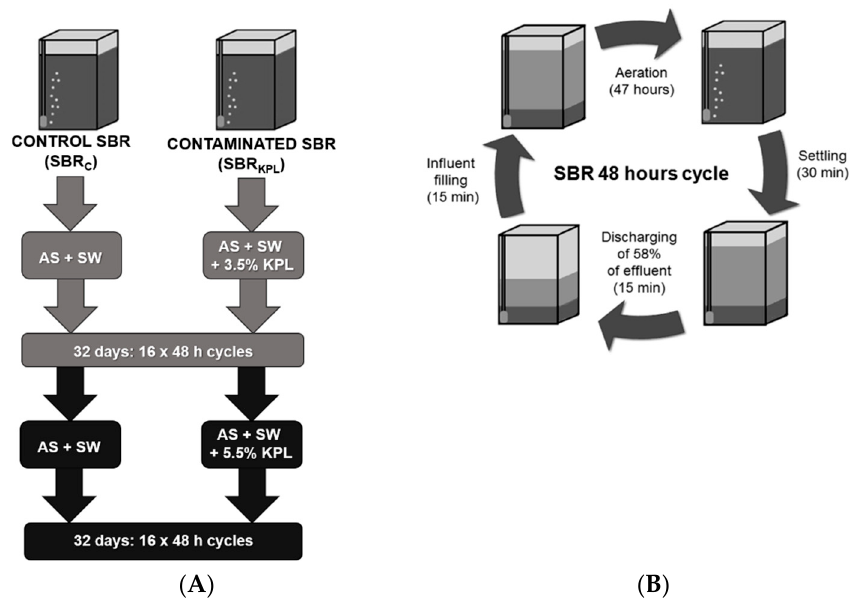
Figure 1. Scheme of experimental setup ( A ) and operation of the sequencing batch reactor (SBR) ( B ).